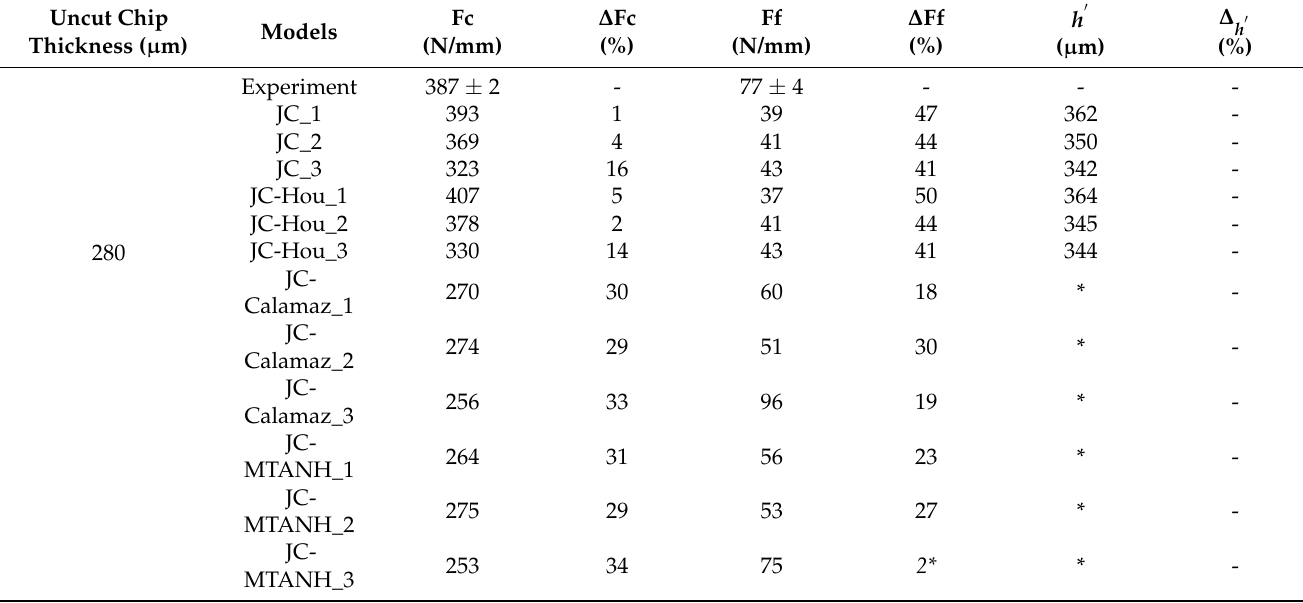
Table 10. RMS cutting force (Fc), feed force (Ff), chip thickness ( h (cid:48) ) and ∆ x differences with the experimental forces of h = 280 µ m.